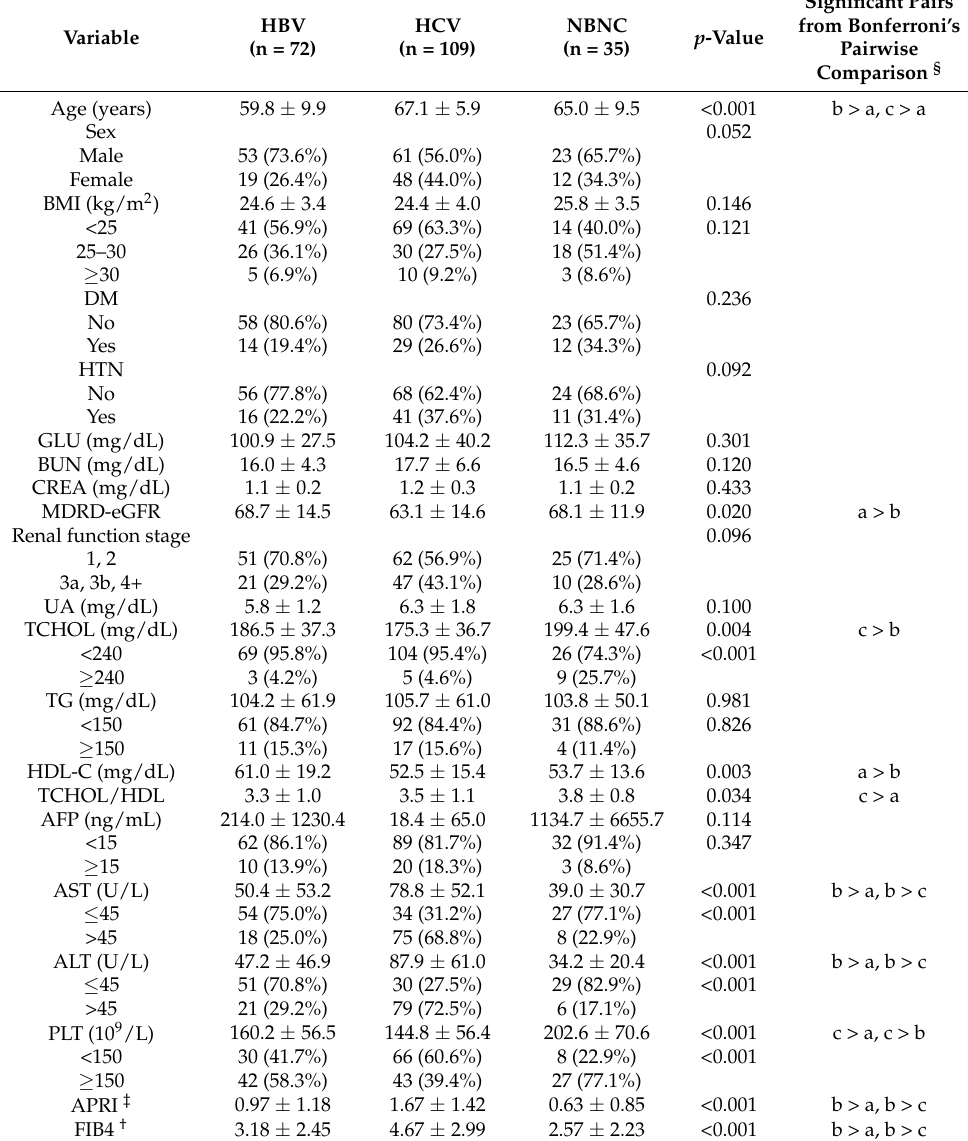
Table 3. Comparison of the clinical features of HCC patients among HBV, HCV, and NBNC